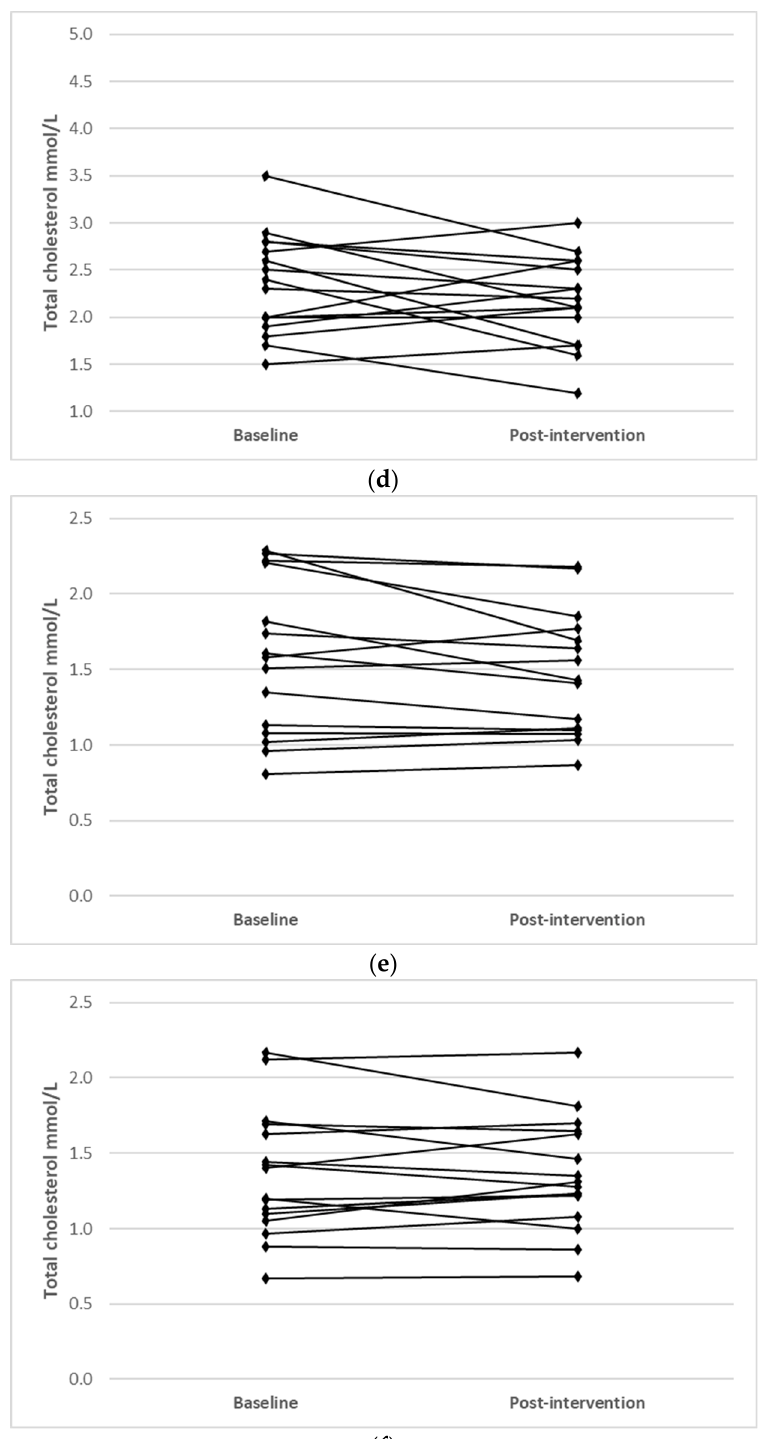
Figure 1. Individual changes from baseline to post intervention in ( a ) TC (IFT group), ( b ) TC (CERT group), ( c ) LDL-C (IFT group), ( d ) LDL-C (CERT group), ( e ) HDL-C (IFT group) and ( f ) HDL-C (CERT group).